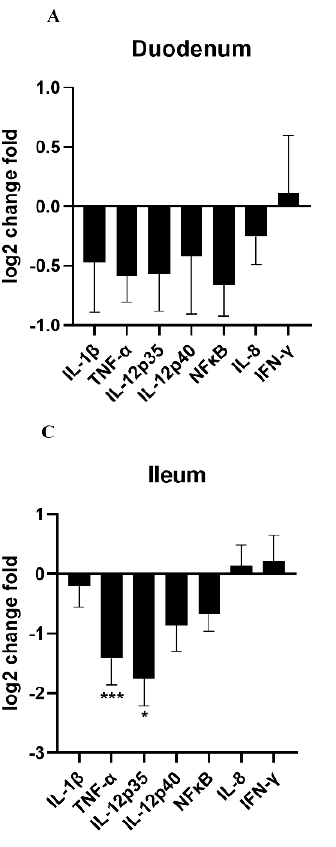
Figure 7. Effects of HDRsEf1 on inflammatory responses in small intestine. ( A – C ) Inflammatory factors in mucosa of duodenum, jejunum, and ileum. n = 5, * p < 0.05, *** p < 0.001.